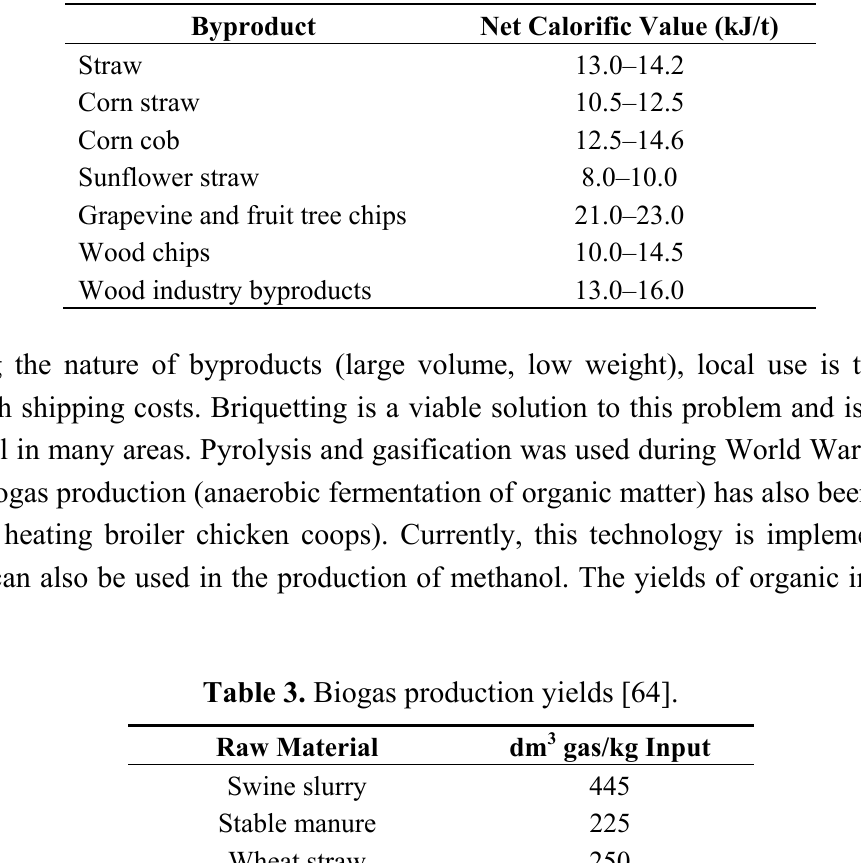
Table 2. Net calorific value of biomass byproducts [64].